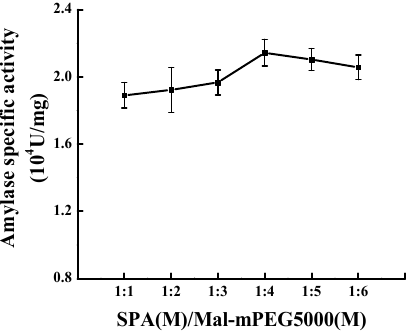
Figure 1. Effect of 6 types of modifiers on SPA activity. Significant difference in each column are expressed as different superscript letters ( p < 0.05).